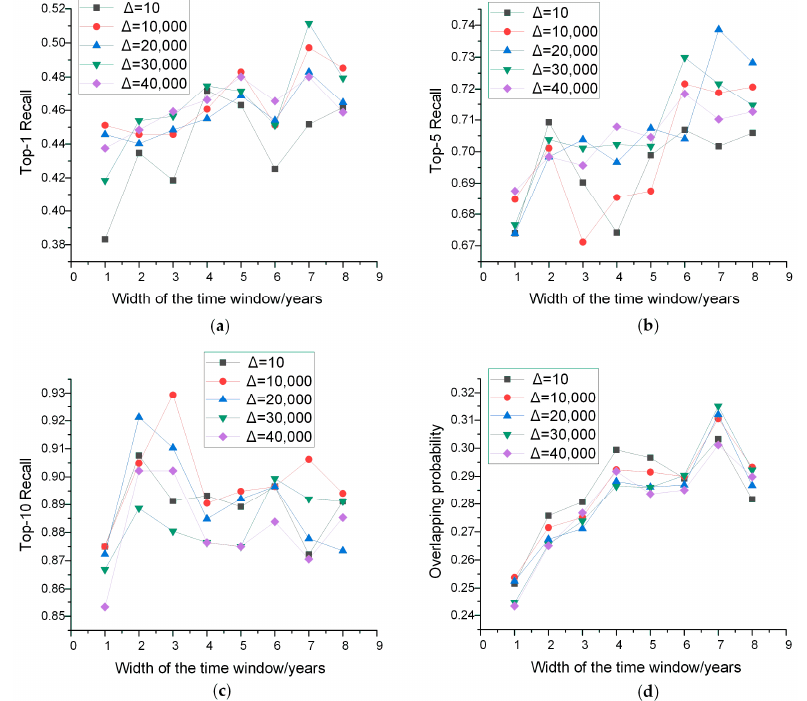
Figure 11. Performance comparison versus time window length and the attenuation coefficient: ( a ) the Top-1 recall versus the model parameters; ( b ) the Top-5 recall versus the model parameters; ( c ) the Top-10 recall versus the model parameters; and ( d ) the overlapping probability versus the model parameters. Table 3. Optimal parameters for different prediction tasks.